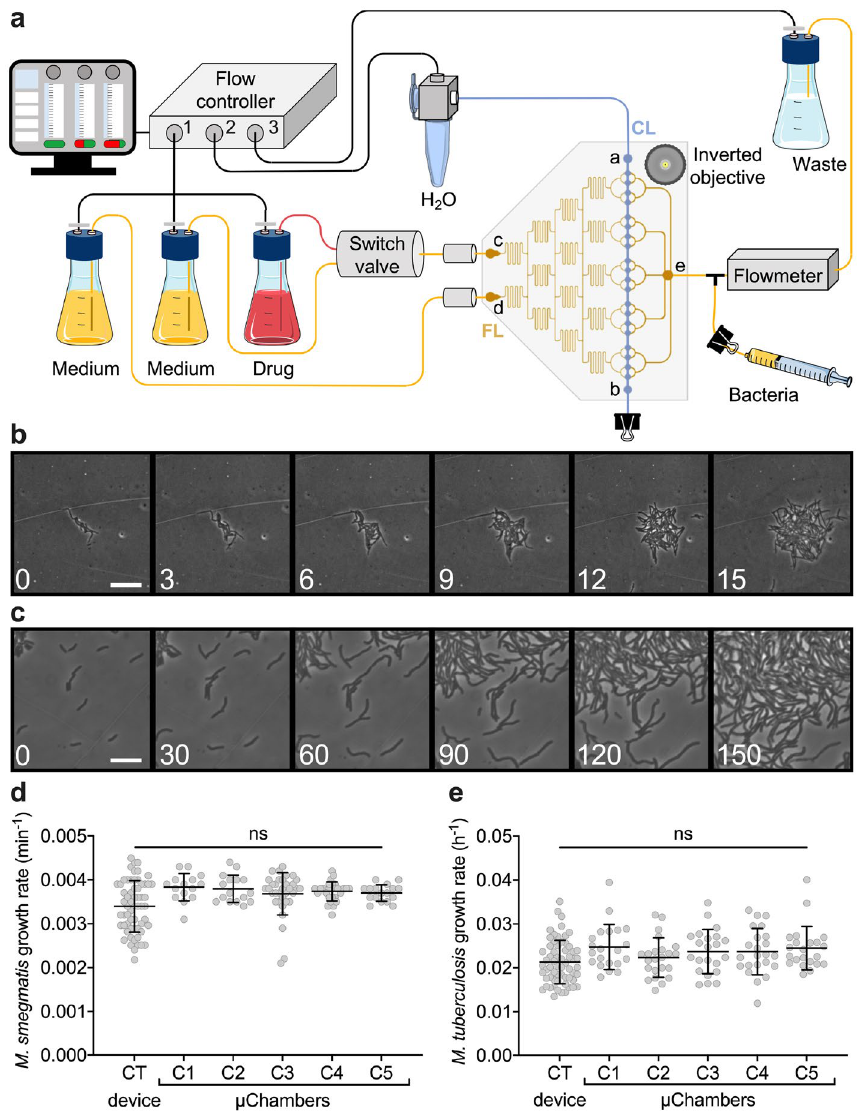
Figure 2. Five-condition platform set-up and validation. ( a ) Schematic of the five-condition microfluidic device connected to a multi-channel microfluidic flow controller (Fluigent). The first channel is connected to three independent reservoirs, in turn connected to a software-controlled bidirectional position valve to switch between conditions. The reservoirs are connected to two inlet ports ( c , d ) of the FL (yellow pattern), and two capacitors (gray cylinders) are integrated upstream of the inlet ports. A software-driven flowmeter is integrated downstream the outlet port of the FL ( e ), which flows into a sealed trash. The outlet tubing is bifurcated via a Y-connector, for bacteria injection. The second channel is connected to the water reservoir, which actuates the membrane from the CL (blue pattern). Filters (0.2 µm) are used at the entry of reservoir and waste bottles to prevent contamination of both fluidics and environment. Time-lapse imaging is carried out from the glass bottom of the device, using a motorized wide-field inverted microscope. ( b , c ) Representative phase-contrast time-lapse image series of exponentially growing M. smegmatis ( b ) and M. tuberculosis ( c ) inside the five- condition device. Cells were imaged at 20-min ( b ) or 3-h intervals ( c ), and numbers represent hours. Scale bars 10 μm. ( d , e ) Microcolony growth rates of M. smegmatis ( d ) and M. tuberculosis ( e ) growing inside different chambers of the five-condition device, and compared to our CT device 44 . Black lines indicate mean ± SD (15 ≤ N ≤ 60, from at least two independent experiments per strain). No significant difference is found by one- way ANOVA followed by Kruskal–Wallis multiple comparisons